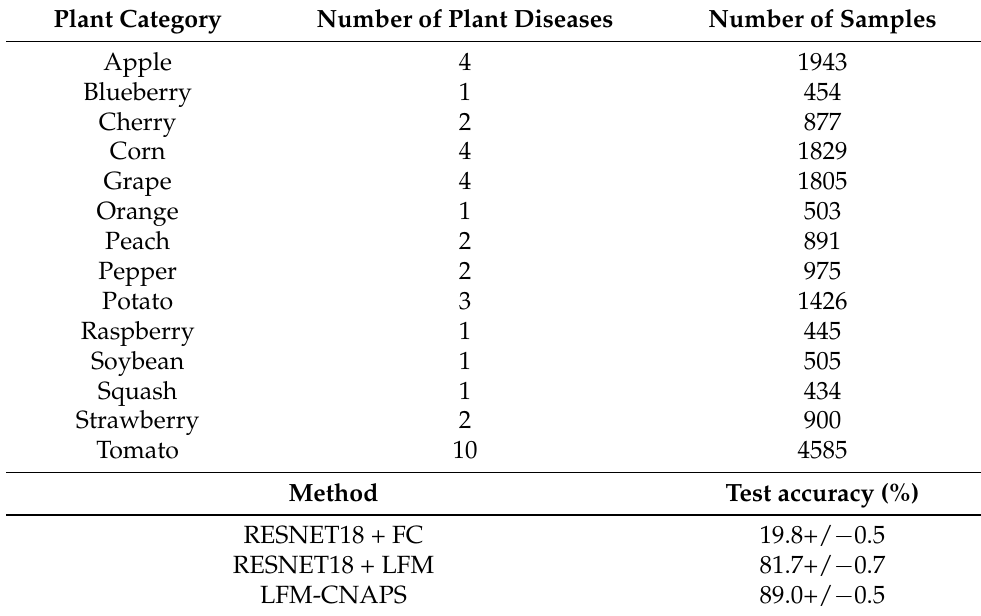
Table 6. LFM-CNAPS test results on a